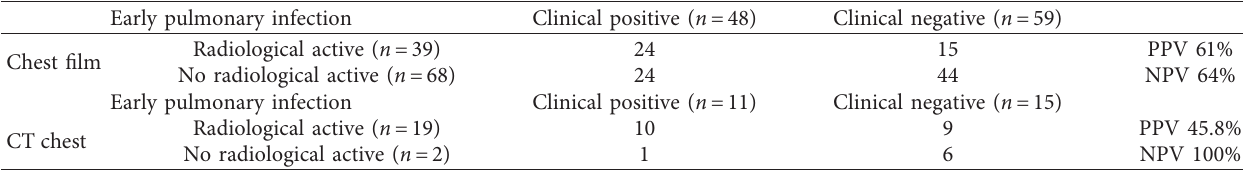
PPV, positive predictive value; NPV, negative predictive